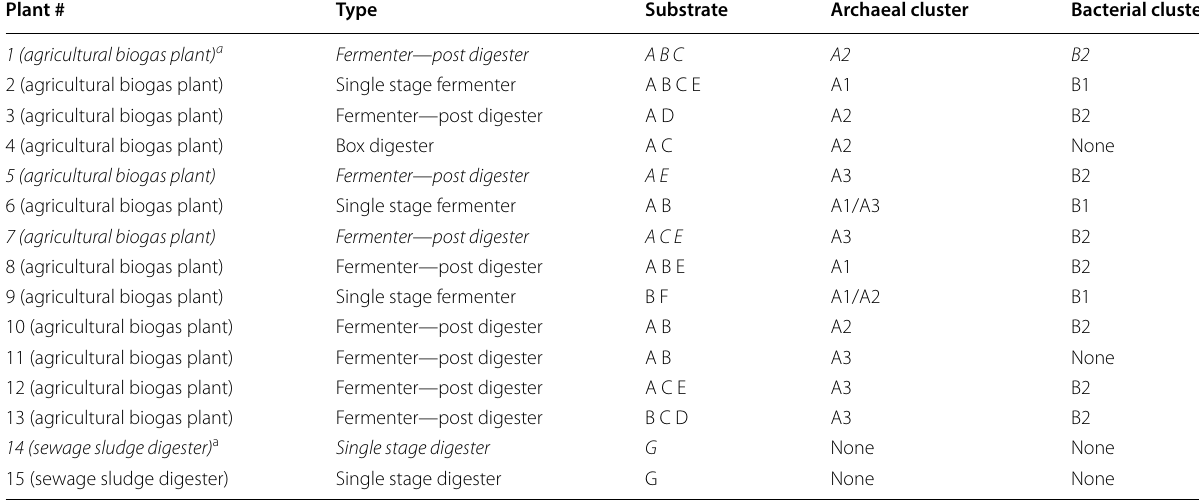
Table 1 Overview of the investigated technical plants